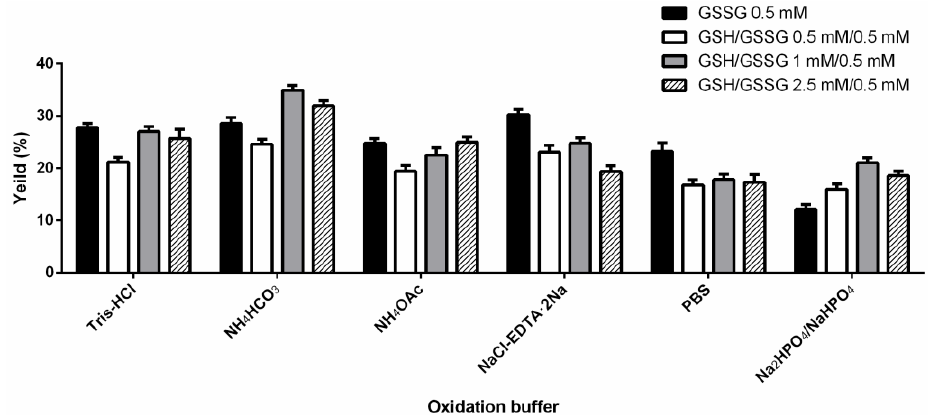
Figure 3. HPLC graphs of folding products of Lv32.1 in 0.1 M NH 4 HCO 3 buffer with 1 mM GSH/0.5